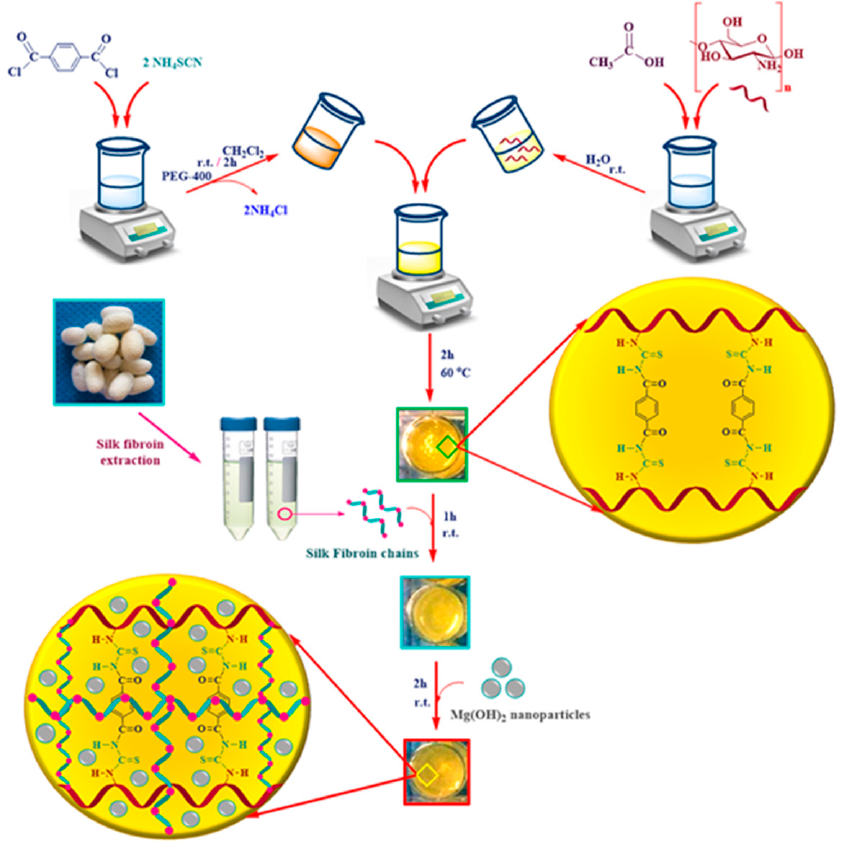
Figure 11. The schematic depiction on the preparation of chitosan hydrogel nanocomposites, adopted from open access resource [42].